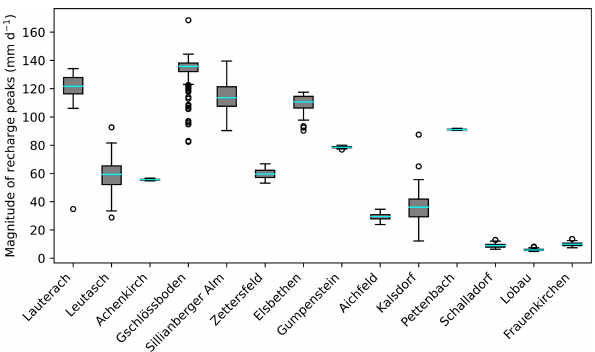
Figure 7. Uncertainty ranges in peaks of the potential recharge flux at 14 Austrian sites. Maximum daily rates of the long-term simu- lation period and propagated posterior uncertainties are presented using box